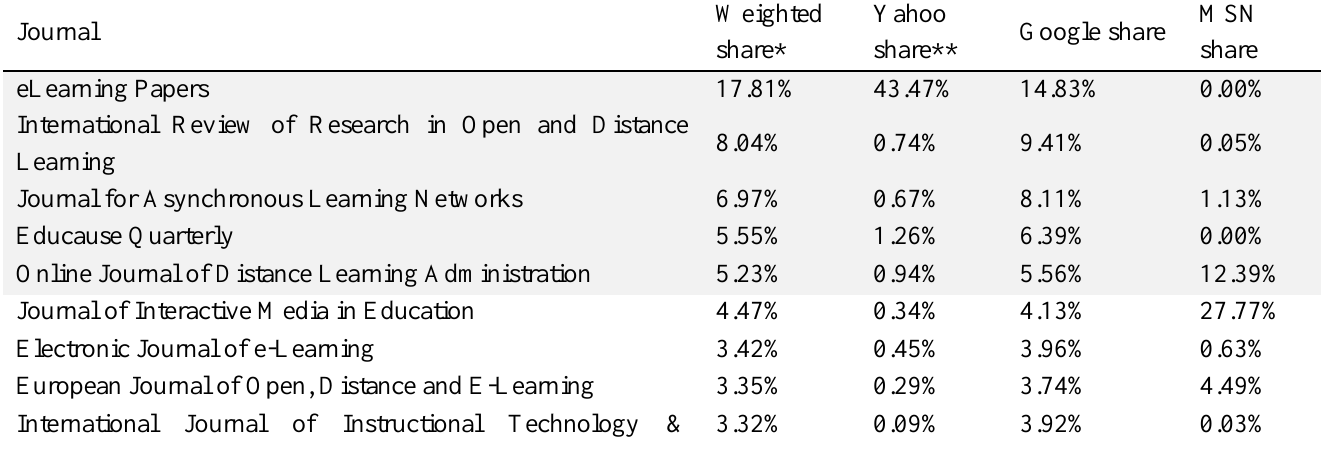
Ranking of Journals Based on Home Page In-Link Percentage Share (N = 46)